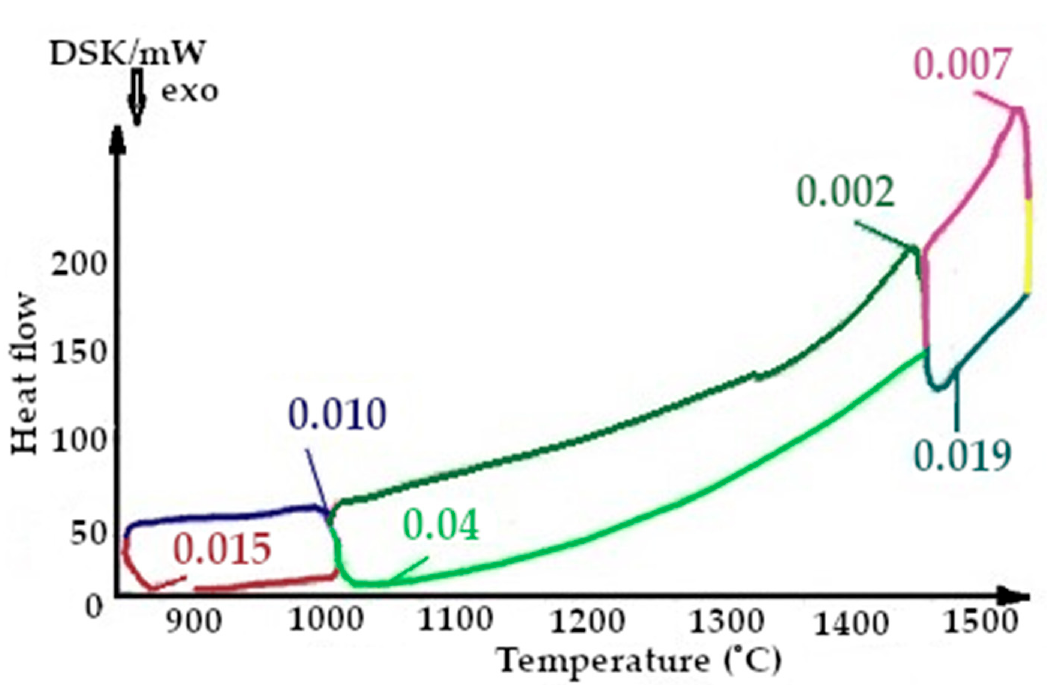
Figure 11. Fragment of the thermogram of quartzite, calcified at a temperature of 200 °C (Cycle 2), where: up to 870 °C,